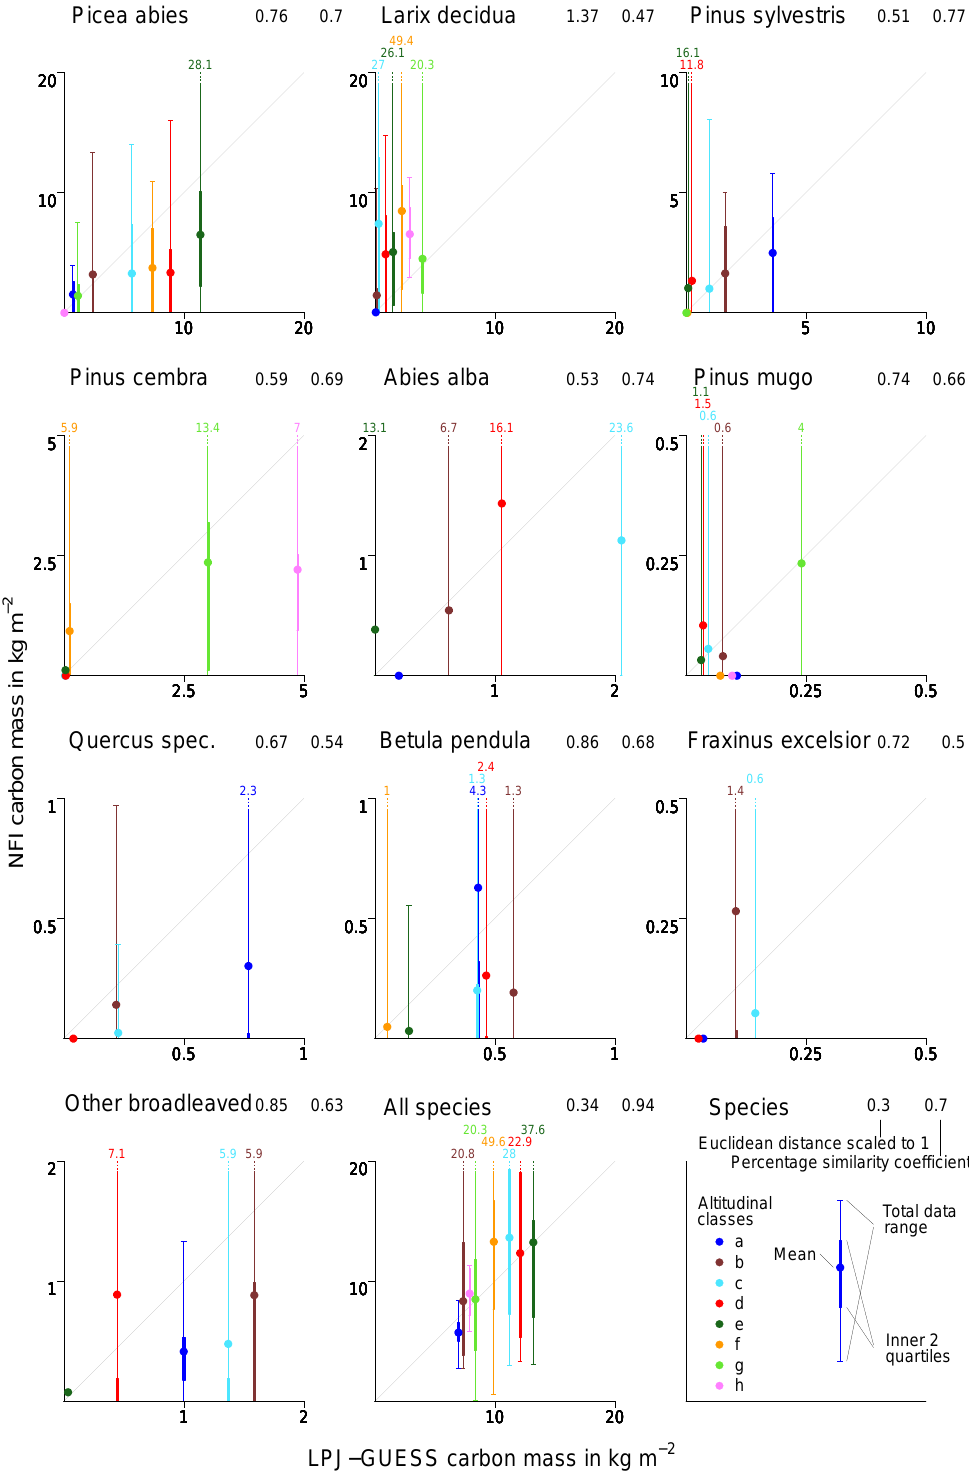
Fig. D.2. Comparison of the NFI3 data with LPJ-GUESS runs. Note that for some species the two inner quartiles of the NFI data are located at 0 in all plots. See Fig. D.1 for description.